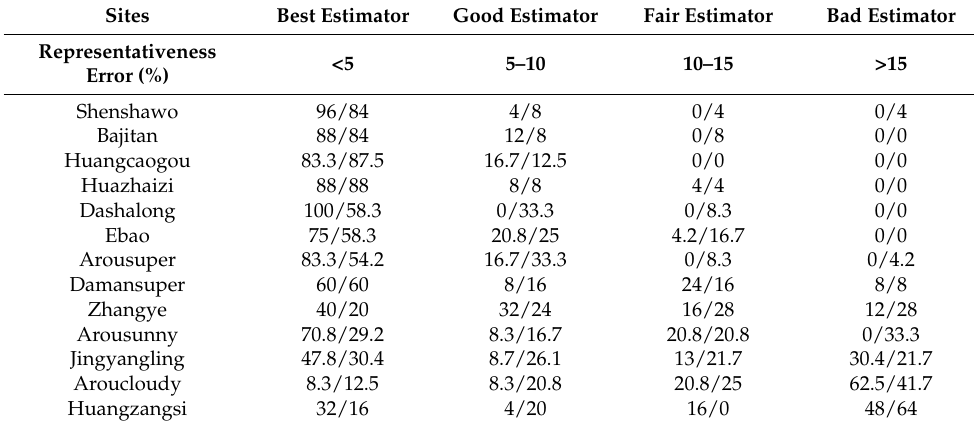
Table 4. Frequency of representativeness errors of ground measurements to the 500 m (left) and 1 km (right)